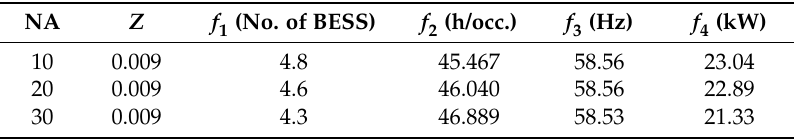
Table 7. Mean values of least upper bound Z and (cid:1858) ℓ for different NA .